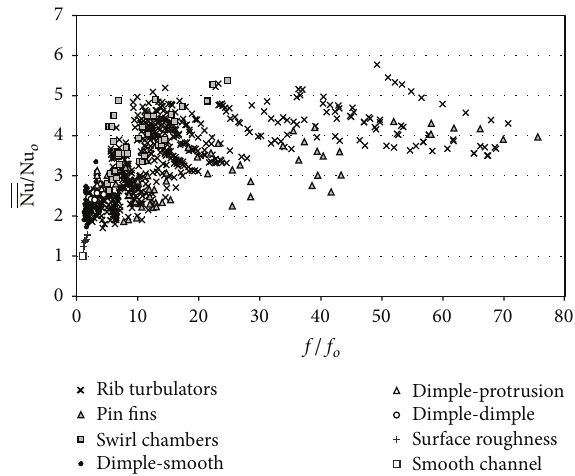
Figure 2: Comparison of relative performance of rib turbulators, pin fins, swirl chambers, dimple-smooth arrangements, dimple- protrusion arrangements, dimple-dimple arrangements, surface roughness, and smooth-walled channels from investigations prior to 2003. Globally averaged Nusselt number ratios Nu / Nu 𝑜 are presented as dependent upon friction factor ratios 𝑓/𝑓 𝑜 [1].